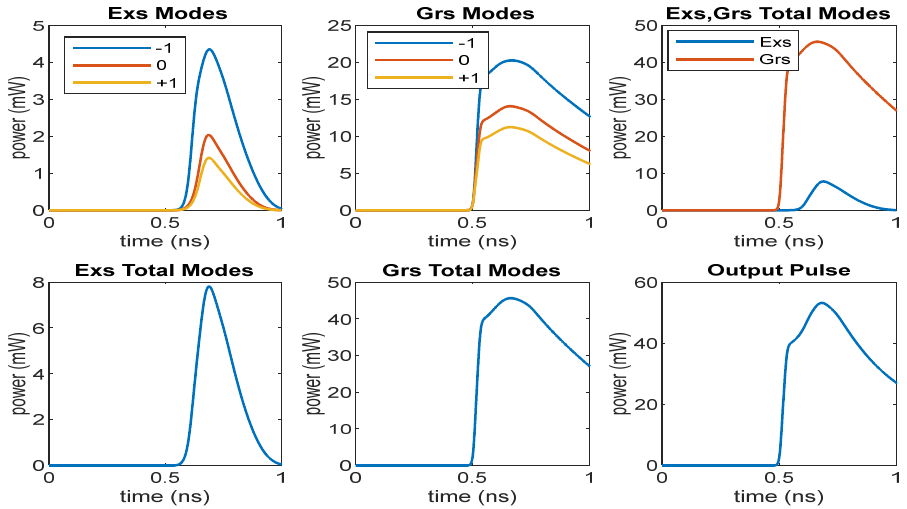
Figure 10. Output pulses for an I rf current of 60 mA for Γ ihom = 30 meV.